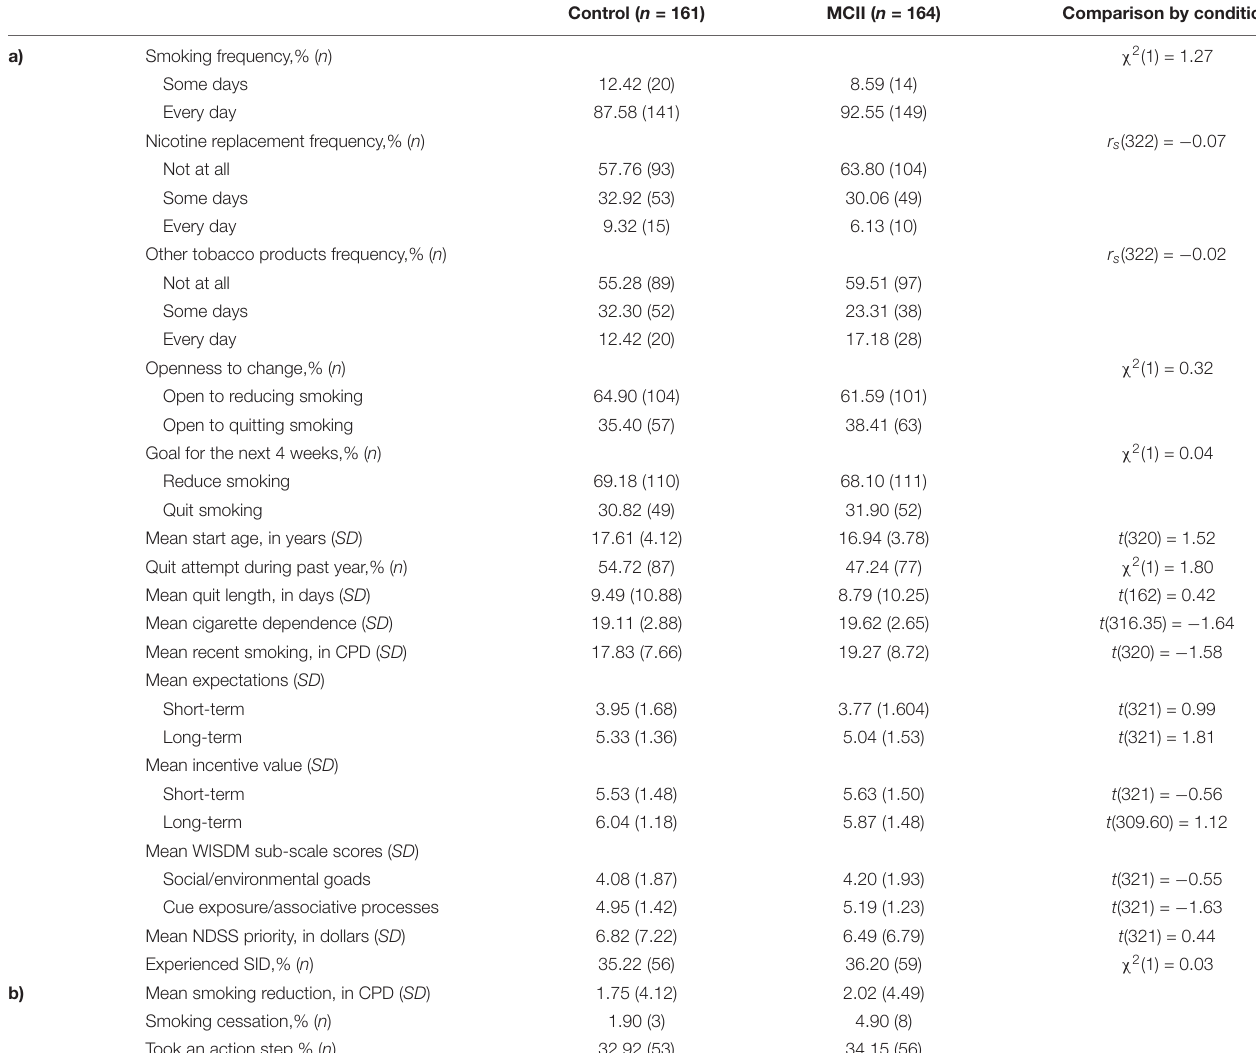
TABLE 1 | Descriptive statistics by condition for (a) baseline (Time 1) smoking-related characteristics and (b) key outcomes. Control ( n = 161) MCII ( n = 164) Comparison by